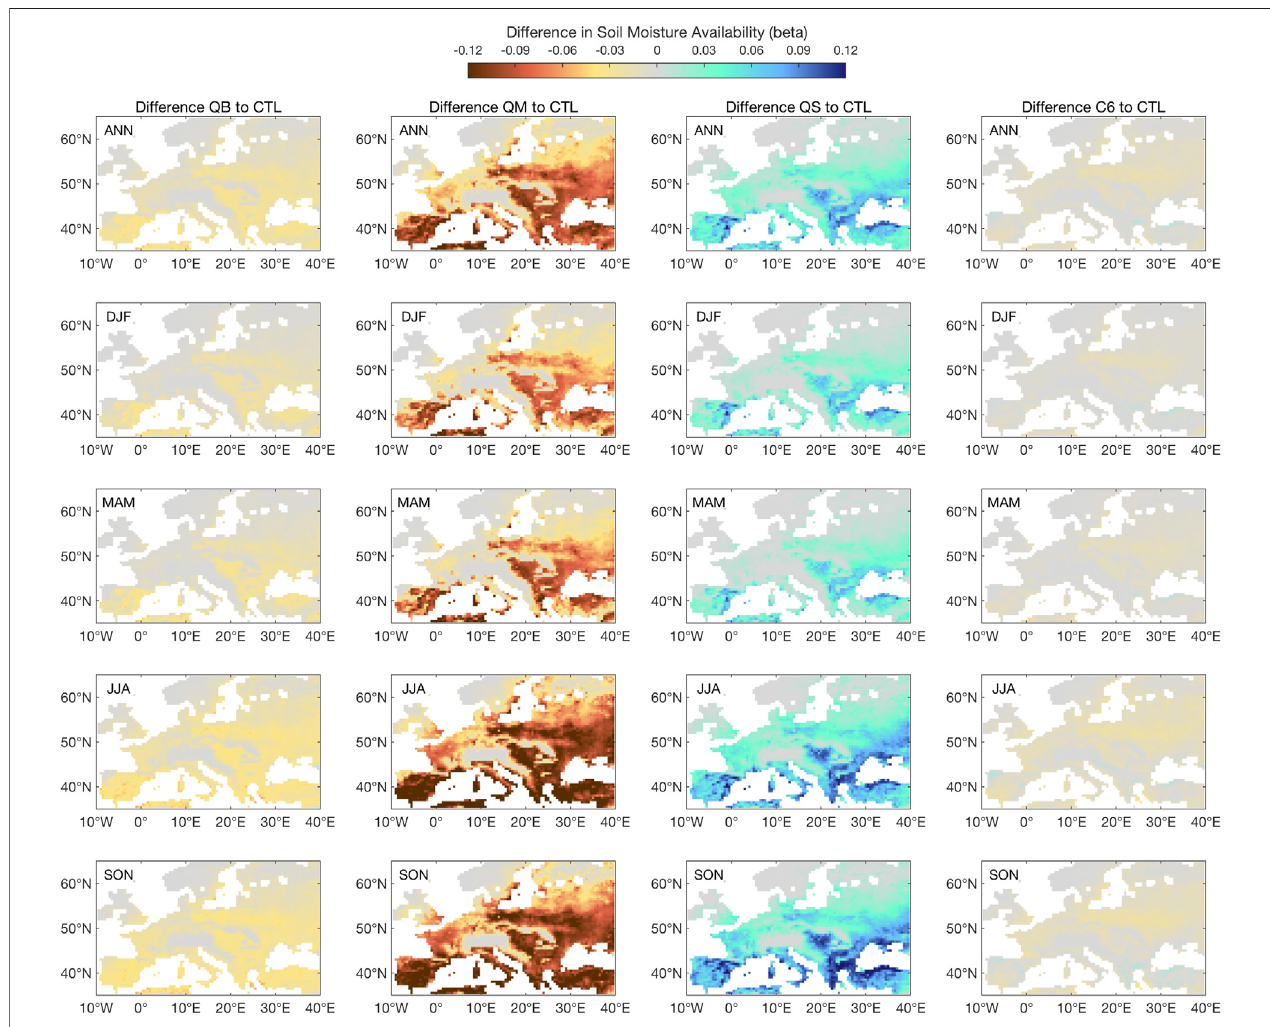
FIGURE 6 | Climatology of available soil moisture, as indicated by ß in each simulation, as compared to the control simulation (CTL). All values apply to the full soil pro fi le. ß is unitless.